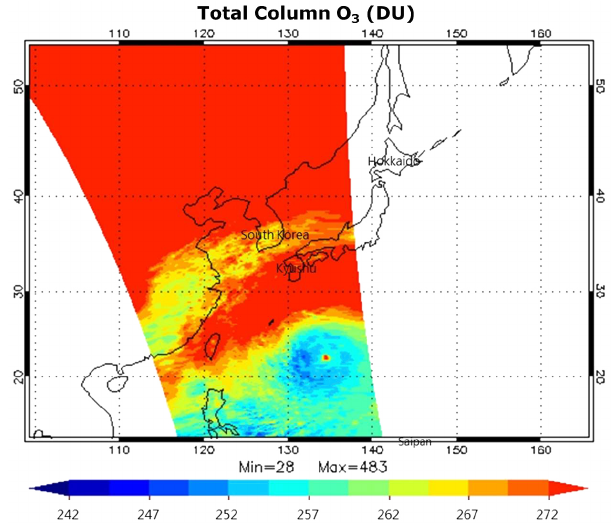
Figure 1. Total column O 3 (in DU) from OMI at 04:05UTC, 3 September